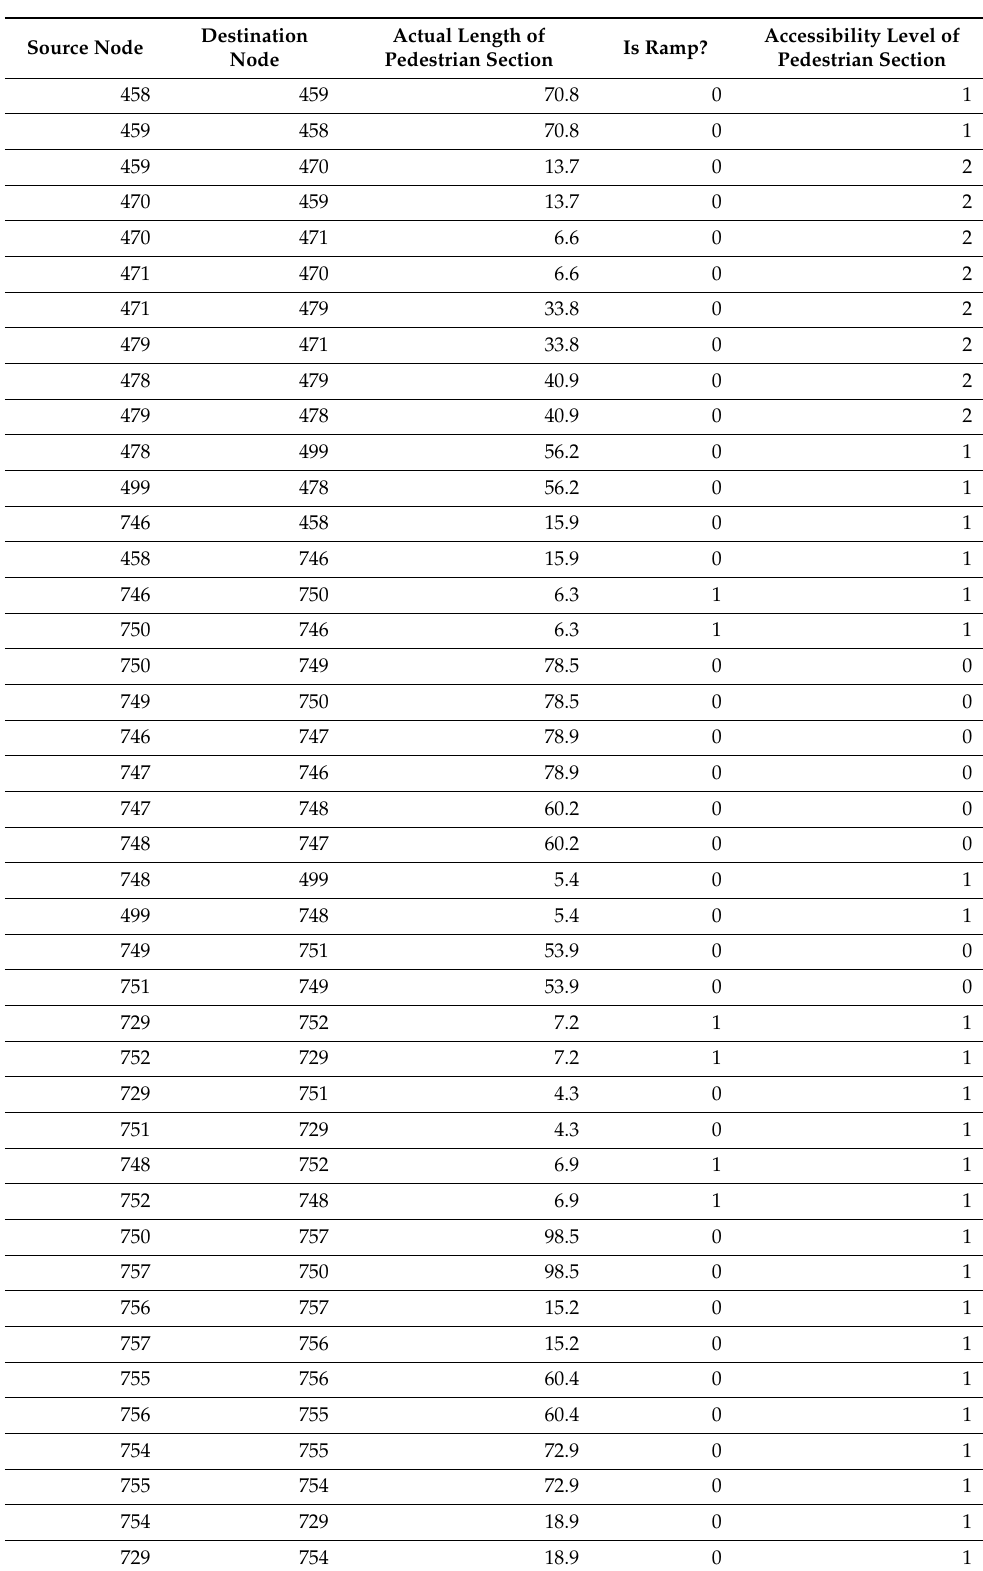
Table A4. Use Case